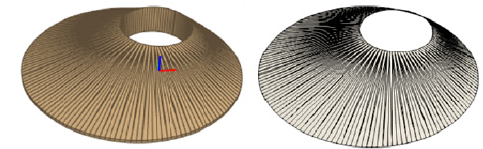
Figure 9. Shrub placeholder (left) and extracted surface (right)